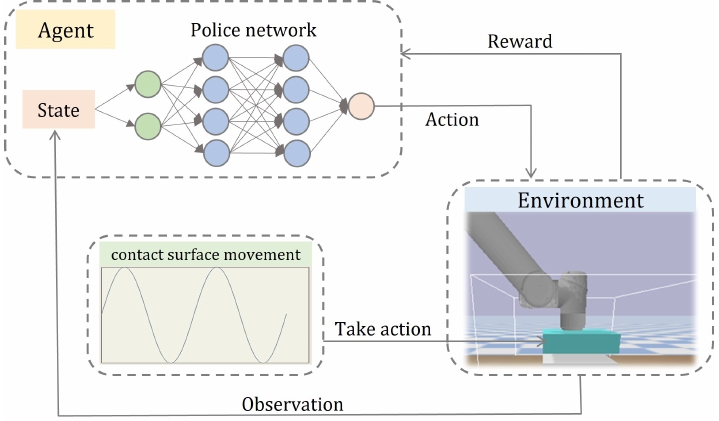
Figure 1. Framework of auscultation strategy. It consists of two parts: a deep reinforcement learning module and a dynamic location module. First, the dynamic position module realizes the contact sur- face position change. Then, the deep reinforcement learning module outputs the manipulator action based on the acquired manipulator state and obtains a reward according to the newly acquired